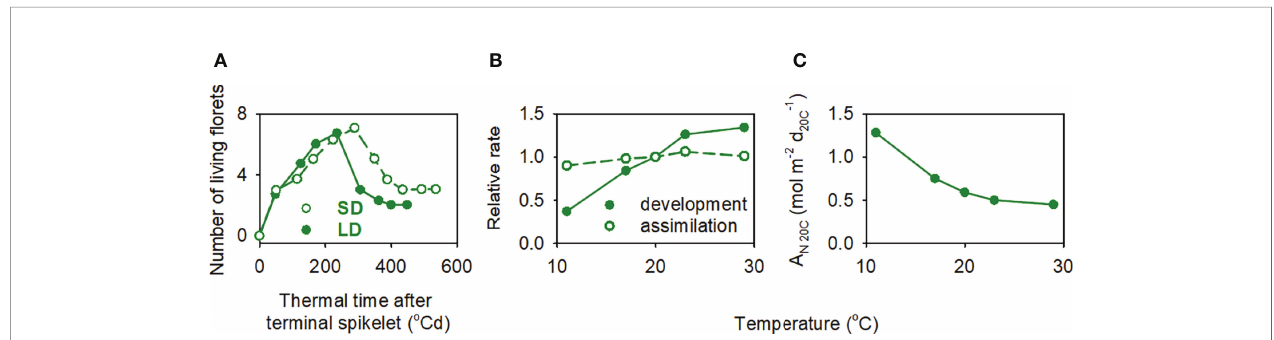
FIGURE 4 | (A) Developmental effect of daylength on fl oret survival of fi eld-grown wheat, where short-day (SD) was the natural photoperiod of the growing season (approximately 12.5 h) and long day (LD) was the natural photoperiod extended by 6 h with a mixture of incandescent and fl uorescent lamps. The photosynthetic photon fl ux density (400 – 700 nm) of the supplementary light was 4 mol m -2 s -1 . (B) Relative rate of developmental processes and CO 2 assimilation normalised to 20 °C in response to ambient temperature. (C) Daily net CO 2 assimilation per unit of developmental time, A N20C , as a function of temperature. Data sources: (A) Ghiglione et al. (2008); (B, C) Lohraseb et al. (2017).